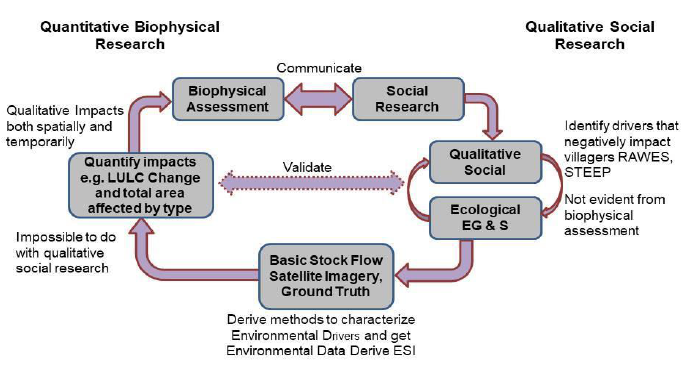
Figure 1. A flow chart to show the interdependencies in qualitative and quantitative research.